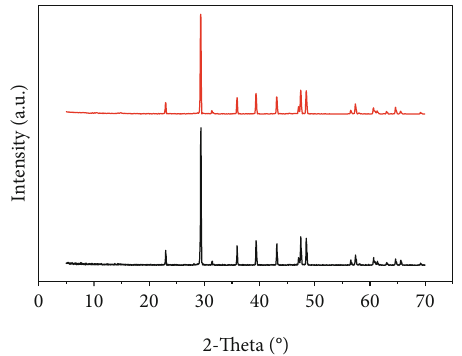
Figure 17: X-ray di ff raction (XRD) analysis of calcium carbonate ) (CaCO 3